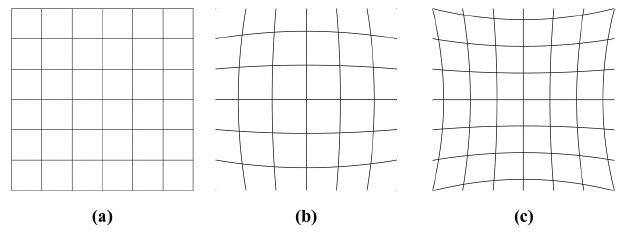
Figure 2. ( a ) Image without distortion and with two common types of radial distortion: ( b ) barrel distortion and ( c ) pincushion